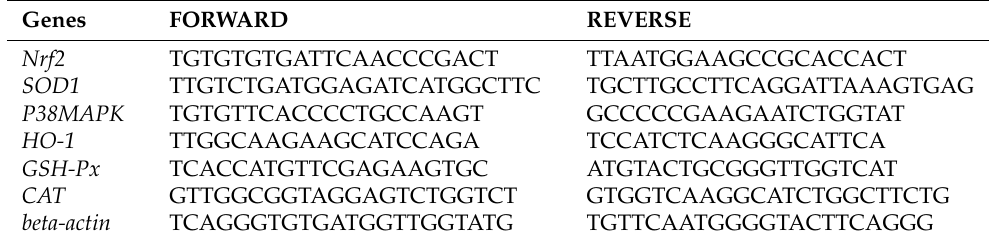
Table 2. Sequences of primer pairs of